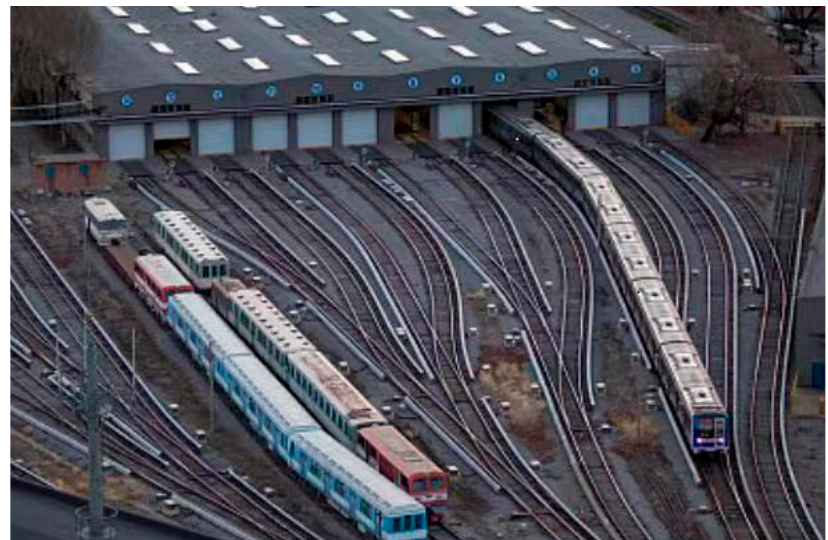
Figure 1. Photograph of a subway yard line.